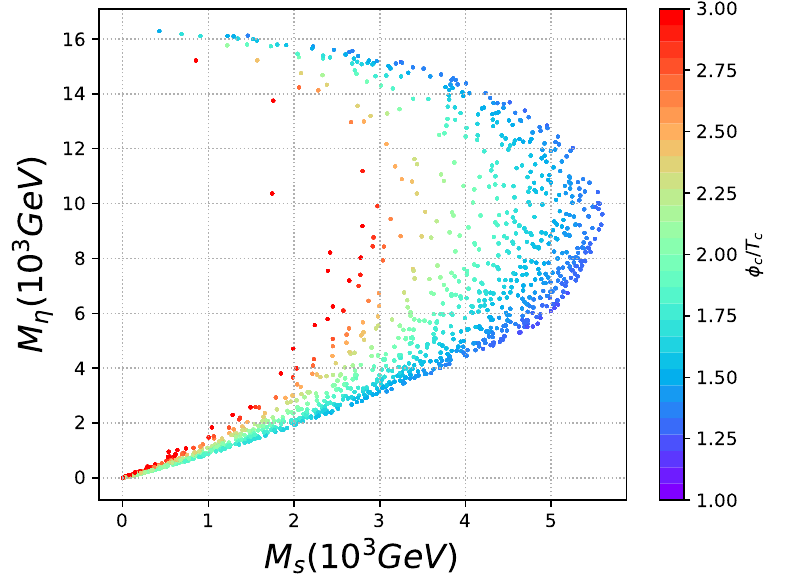
Figure 2 . Parameter space in inert doublet Mass M η versus scalar singlet mass M S plane consistent with a FOPT in conformal scotogenic model. The colour code indicates the strength of the FOPT.